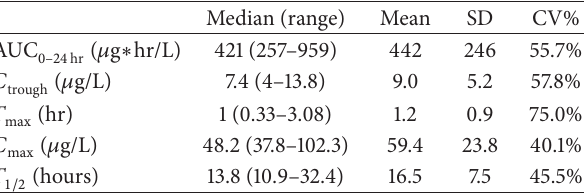
Table 5: Summary of everolimus pharmacokinetic parameters. Median (range) Mean